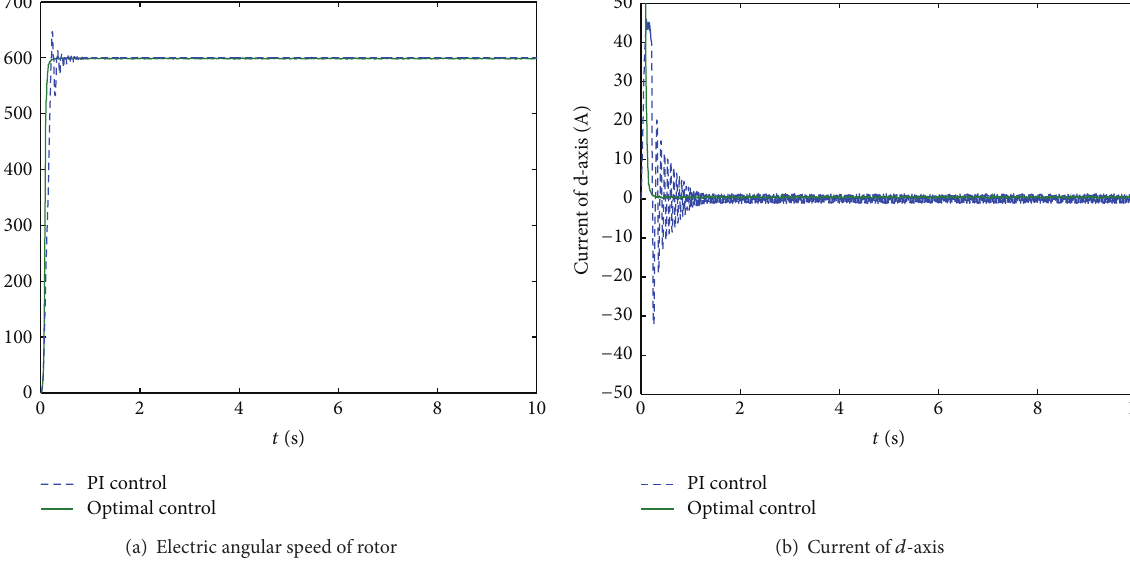
Figure 4: The simulation results of case I (always cutting off the energy storage device).